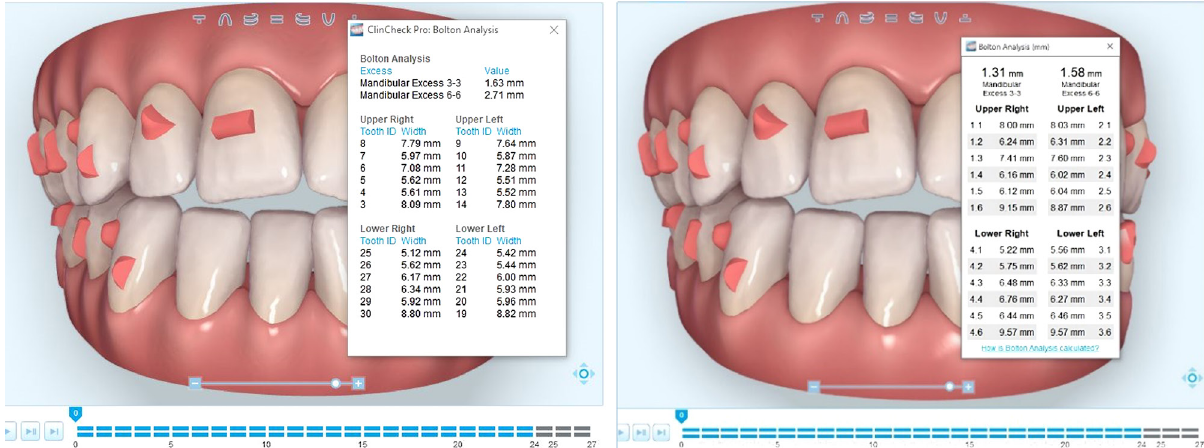
Figure 1. Tooth measurements supplied for the same case showing variations between different versions of ClinCheck. Left is using Old CC Pro, right is New CC Pro.